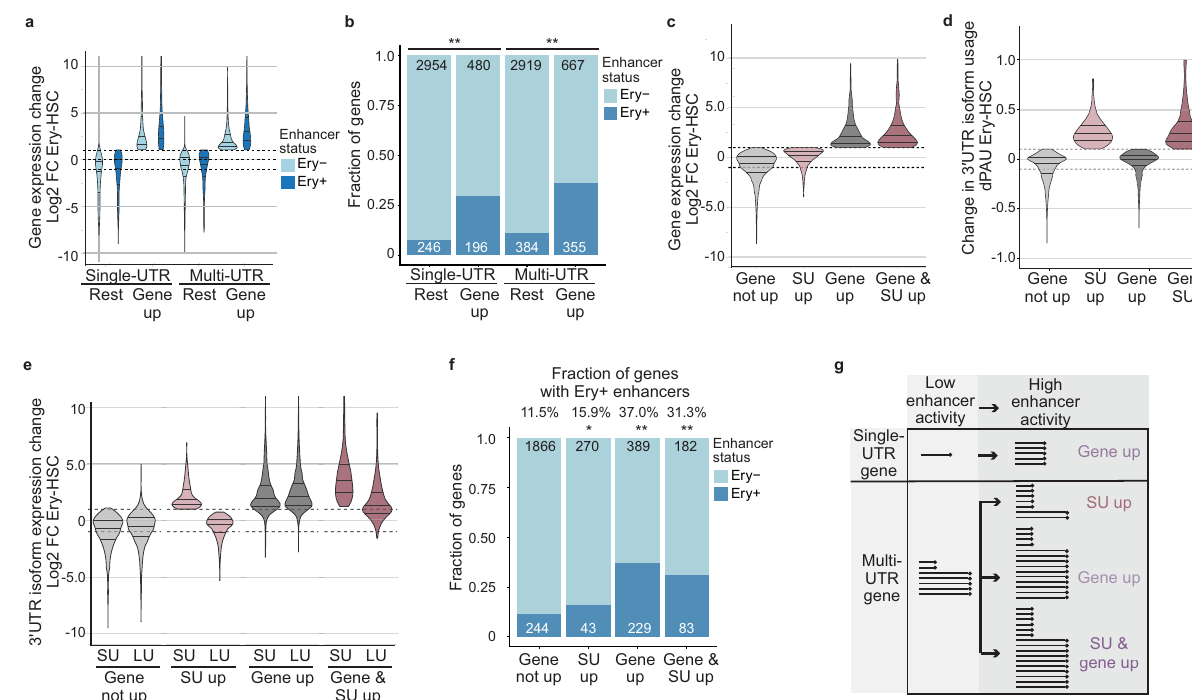
Fig. 5 Cell type-speci fi c enhancers are associated with genes that upregulate SU isoforms. a Fold change (FC) in gene expression between erythroblasts (Ery) and hematopoietic stem cells (HSC) is shown for single- and multi-UTR genes separately. The genes that associate with erythroblast-speci fi c enhancers (Ery + ) are shown separately. Violin plots denote median, 25th and 75th percentiles. The number of genes in each group is shown in ( b ). b Fraction of genes associated with erythroblast-speci fi c enhancers (Ery + ) in the groups from ( a ). Chi-square tests were performed. Single-UTR genes: X 2 = 249, ** P < 10 − 16 . Multi-UTR genes: X 2 = 293, ** P < 10 − 16 . Ery-, genes without an erythroblast-speci fi c enhancer in the vicinity. c Multi-UTR genes were separated based on their gene expression change using DESeq2 with a minimum FC > 2 into two groups ( “ gene up ” and “ gene not up ” ). These groups were further subdivided based on signi fi cant upregulation of their SU isoforms ( “ SU up ” requires an absolute and relative increase (TPM FC > 2 and dPAU > 0.1, DEXseq, P < 0.05, 10% FDR), whereas the control group requires SU isoforms not to be upregulated (TPM FC < 2 and dPAU < 0.1, DEXseq, P > 0.05). FC in gene expression in the indicated groups is shown as in ( a ). The number of genes in each group is shown in ( f ). The PAU is a measure introduced by QAPA and indicates the relative usage of a 3 ′ UTR isoform. Here, we only consider SU isoform usage for the PAU. dPAU is the differential PAU. d Change in 3 ′ UTR isoform ratio as determined by a change in PAU for the groups from ( c ). e FC in 3 ′ UTR isoform expression shown for SU and LU isoforms in the groups from ( c ). f Fraction of genes associated erythroblast-speci fi c enhancers (Ery + ) in the groups from ( c ). Chi-square tests were performed in comparison with the “ gene not up ” group: “ SU up ” , X 2 = 4.3, * P = 0.038; “ gene up ” , X 2 = 215, ** P < 10 − 16 ; “ gene and SU up ” , X 2 = 75.7, ** P < 10 − 16 . g Model showing enhancer-mediated increase in gene expression for single-UTR genes (top). Enhancer-mediated effect for multi-UTR genes can result in increased 3 ′ UTR isoform expression, increased gene expression or an increase in both parameters. The lines with the black dots signify processed transcripts that contain a poly(A)